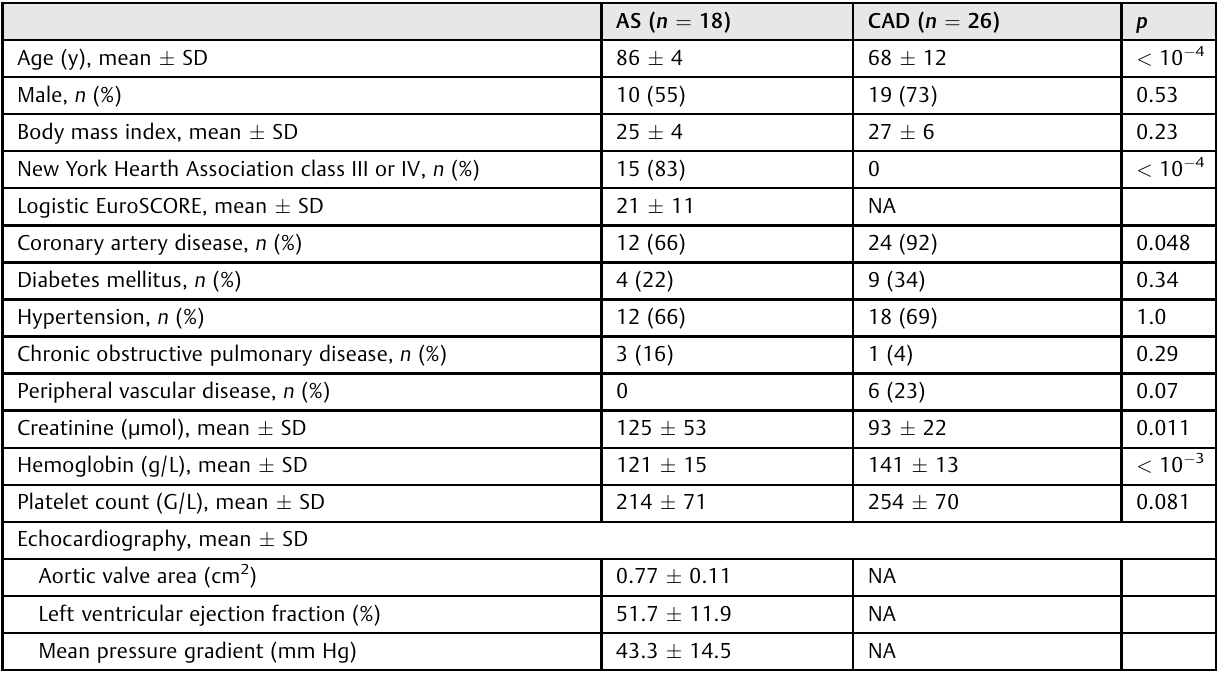
Table 1 Key baseline demographic and clinical data of patients in AS before TAVI and CAD groups